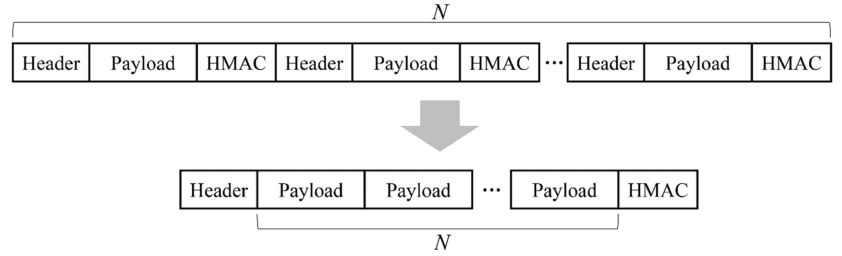
Figure 4. An example of data aggregation in the worst